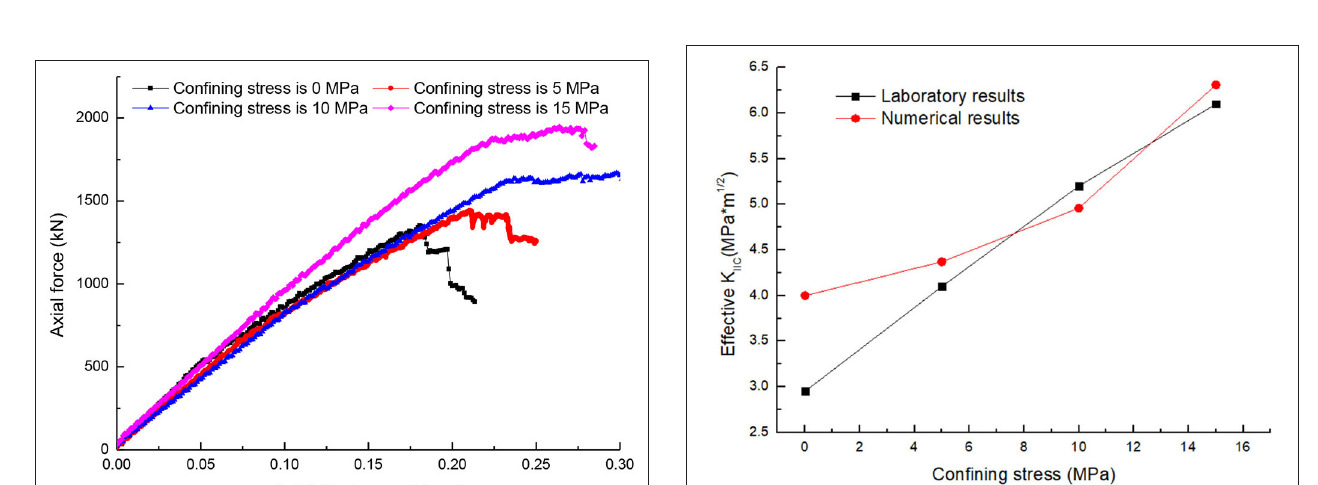
FIGURE 7 | Numerical fractures: (A–D) are the fractures when the confining stresses are 0, 5, 10, and 15 MPa, respectively.